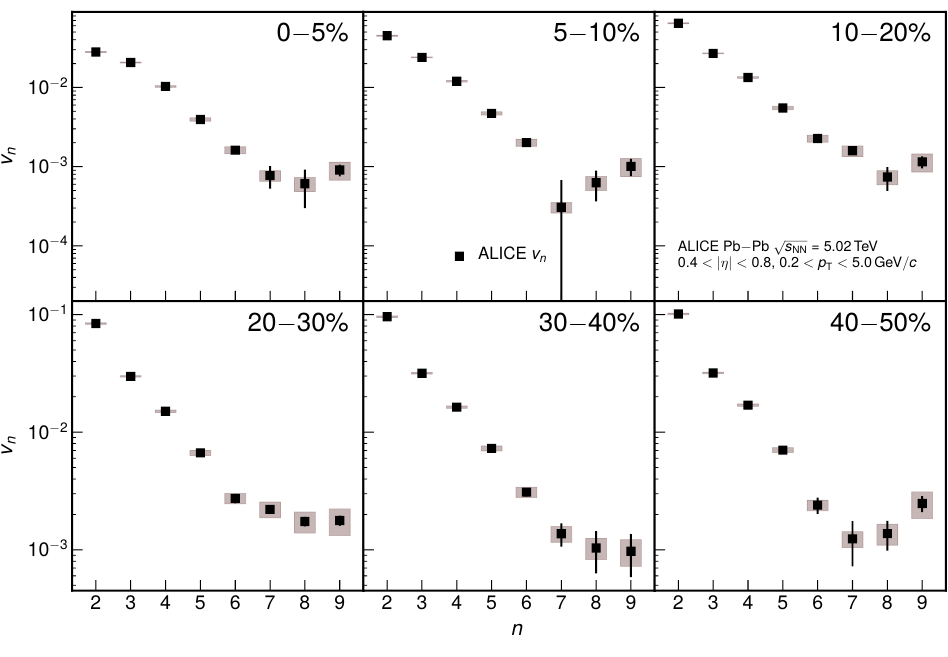
Figure 3 . v n as a function of the harmonic order n for various centrality